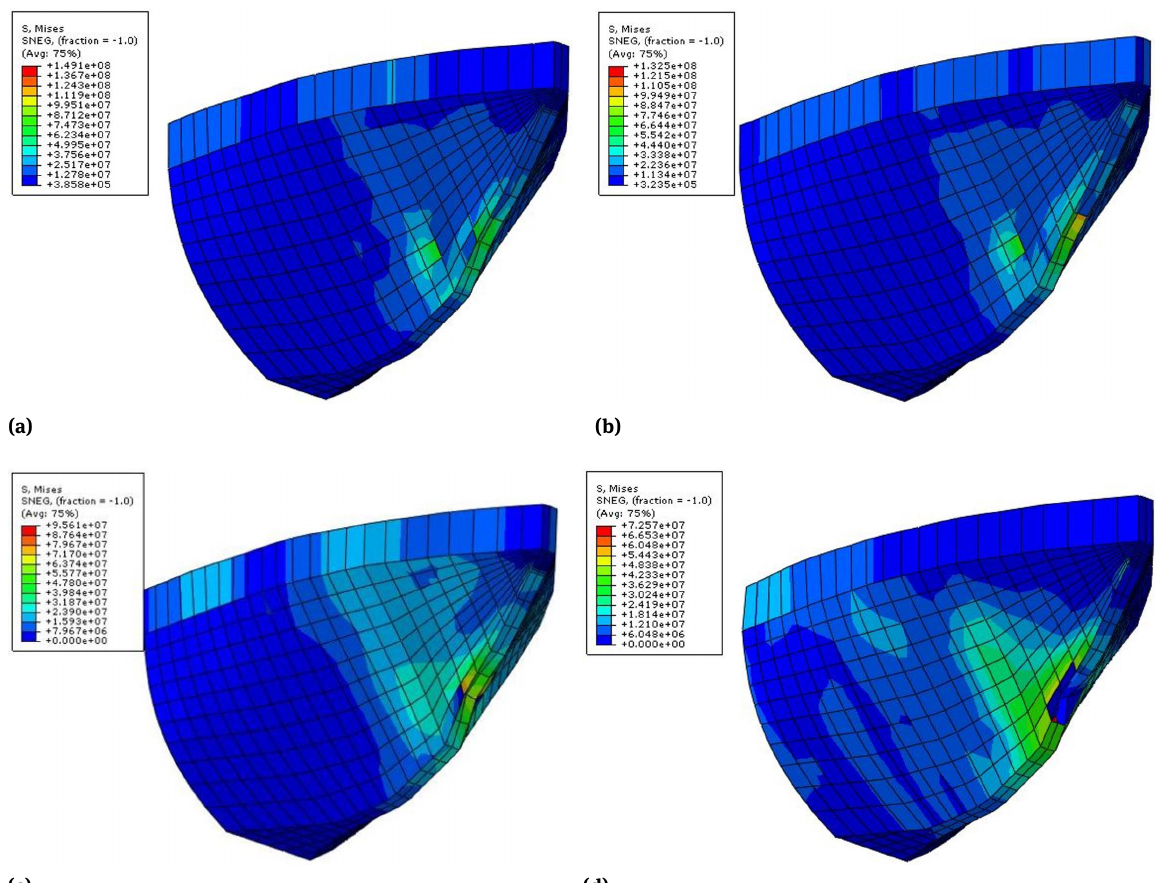
Figure 28: Deformation of the hull construction due to impact at a speed of 3 knots: (a) Laminate type 1, (b) Laminate type 2, (c) Laminate type 3, (d) Laminate Type